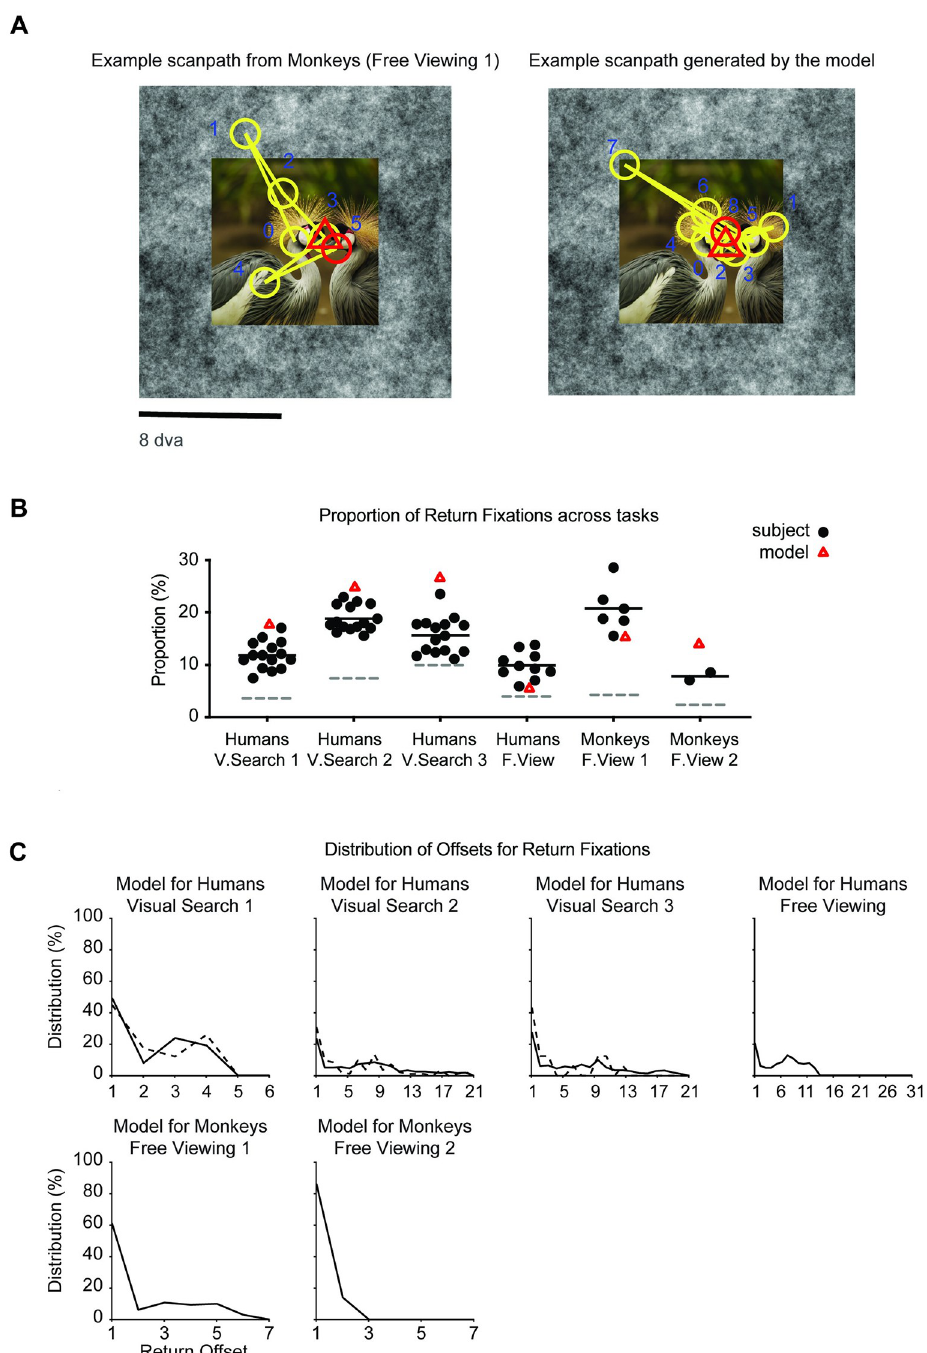
Fig 8. The computational model generates return fixations. ( A ). Example scanpaths by monkeys and by the model while free viewing natural images (conventions follow those in Fig 1.) ( B ) Proportion of return fixations. The black dot denotes the proportion of return fixations for each subject (reproduced from Fig 3A–3H). The red triangle denotes the proportion of return fixations for the model. Black solid lines show average across subjects and gray dashed lines show chance level. (C) Distribution of the return offset for the model (format as in Fig 3J). Photo sources: (A) Reproduced with permission from BPRC and pexels.com.